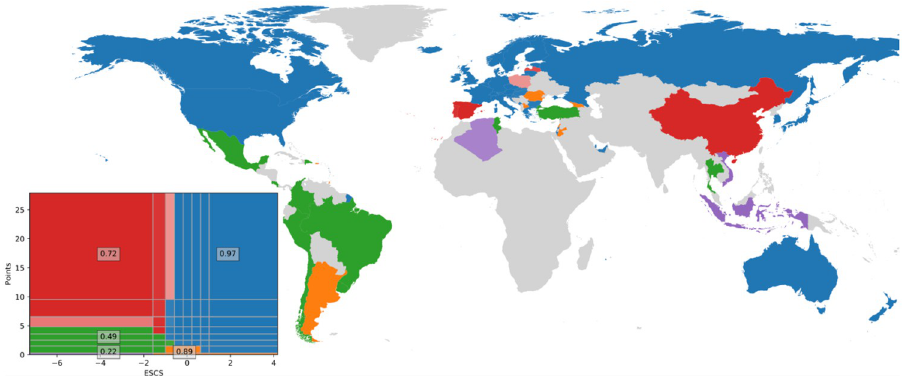
Fig 4. The clusters resulting from the network representation of the PISA data. The blue cluster is characterized by privileged students over the whole scale of performance. The green and purple clusters have less privileged students performing poorly. The red cluster has under-privileged students that perform well in PISA. The bootstrap support for the clusters is indicated by the numbers in the inset, and the node significance by the transparency of the colors.